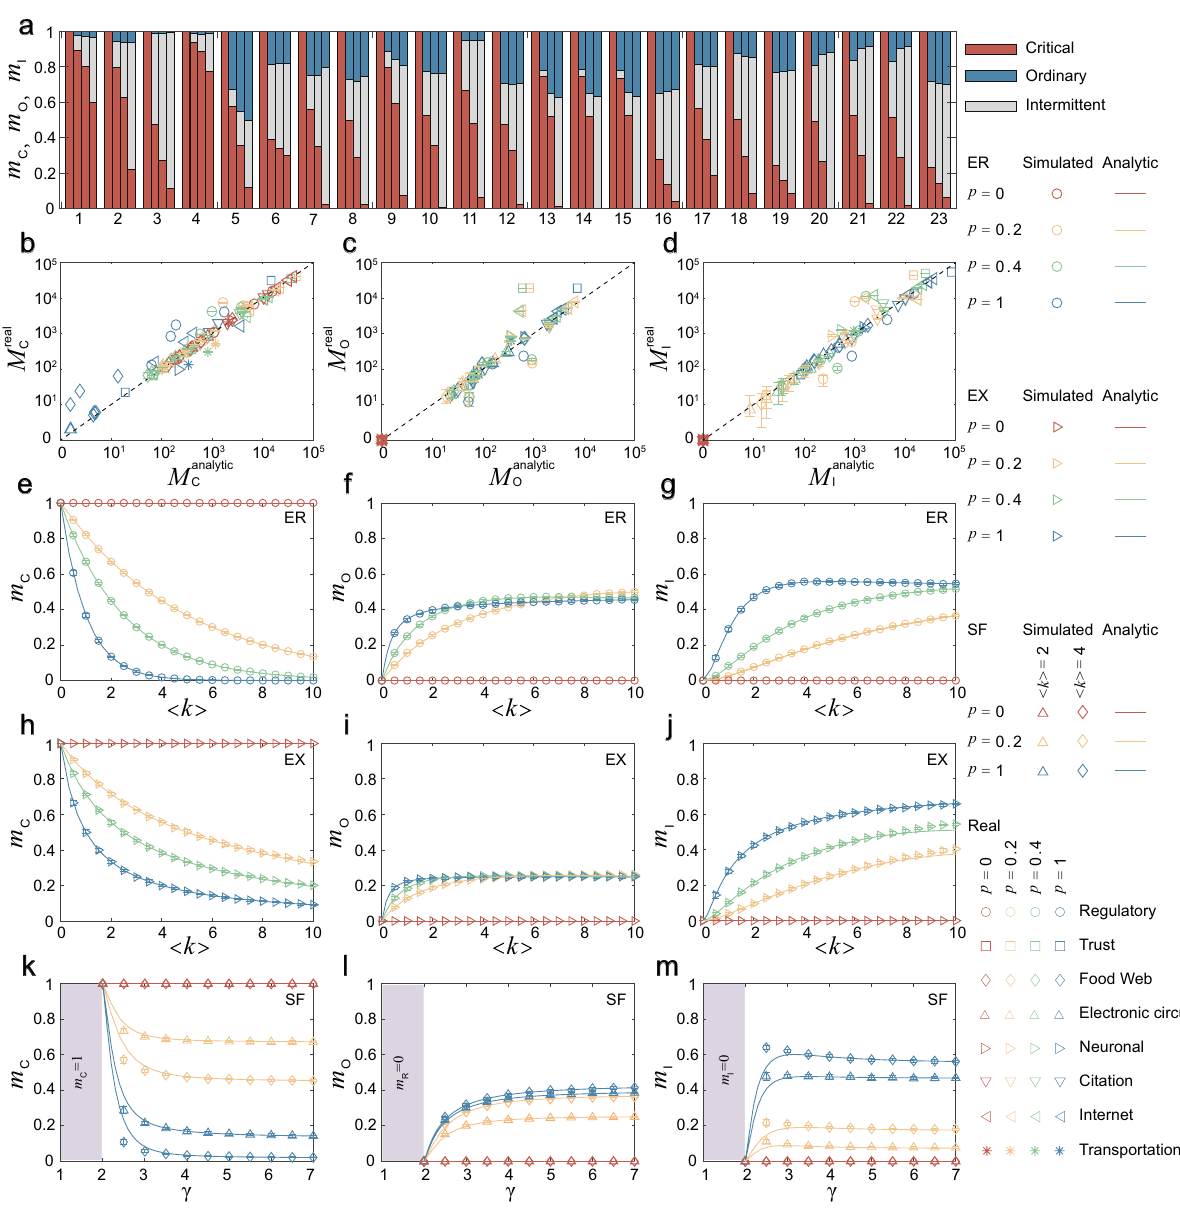
Figure 4. The Role of Edges. ( a ) The proportion of critical m C , ordinary m O , and intermittent m I edges in each real network with the coupling density P = 0 , P = 0.2 , P = 0.4 , and P = 1 , respectively. The proportion ( b ) M analytic M analytic M analytic C , ( c ) O , and ( d ) I obtained by theoretical prediction, compared with the real results. The variation of m C , m O , and m I in ( e – g ) ER networks, ( h – j ) EX networks, and ( k – m ) SF networks as the function of the coupling density P , the average degree (cid:31) k (cid:30) and the power exponent γ ,